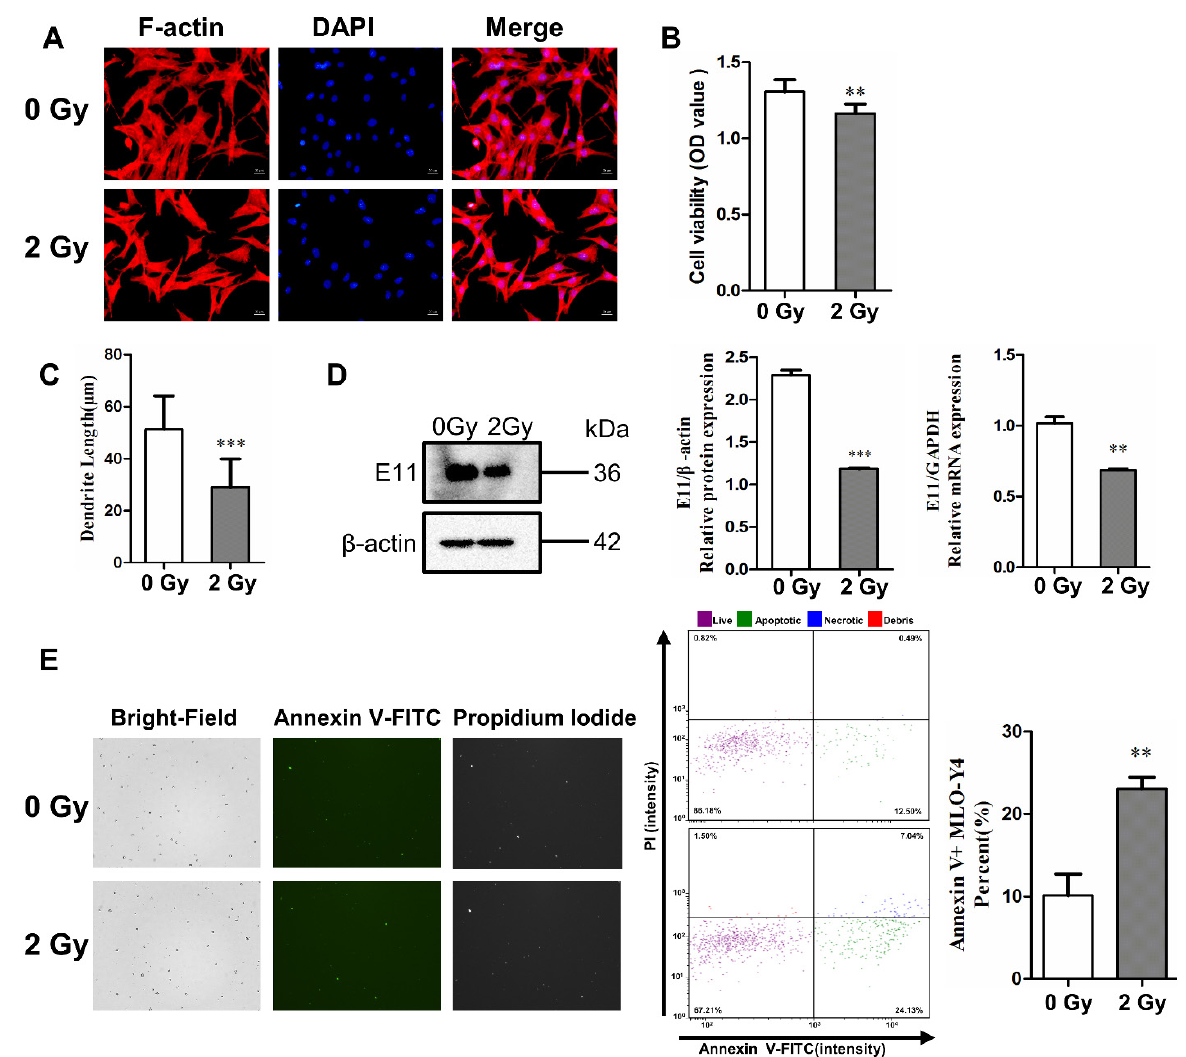
Figure 1. γ -ray irradiation inhibited dendrite elongation and cell activity, and it induced the apoptosis of osteocyte-like MLO-Y4 cells. ( A ) Morphological change in MLO-Y4 cells after 3 days post irradiation. F-actin (red) was stained with phalloidin, and nuclei (blue) were stained with DAPI; magnification = ×200. ( B ) Quantifying cell viability with Cell Counting Kit-8; n = 6. ( C ) The length change in dendritic structures in MLO-Y4 cells post irradiation; n = 5. ( D ) Detection of E11 mRNA and protein expression; n = 3. ( E ) Bright field (left column) and fluorescence images of Annexin V-FITC (middle column) and PI (right column). The images show an increase in the number of both apoptotic and necrotic cells post irradiation. Cytometer assay for the apoptosis of MLO-Y4 cells 3 days post irradiation; n = 3. PI: propidium iodide. Results are expressed as mean ± SD (** p < 0.01; *** p < 0.001 vs. 0 Gy).